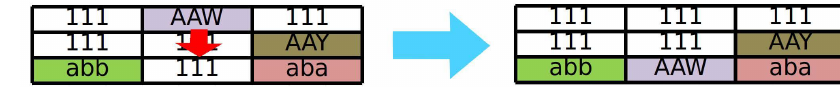
Figure 6. Third neighborhood example.